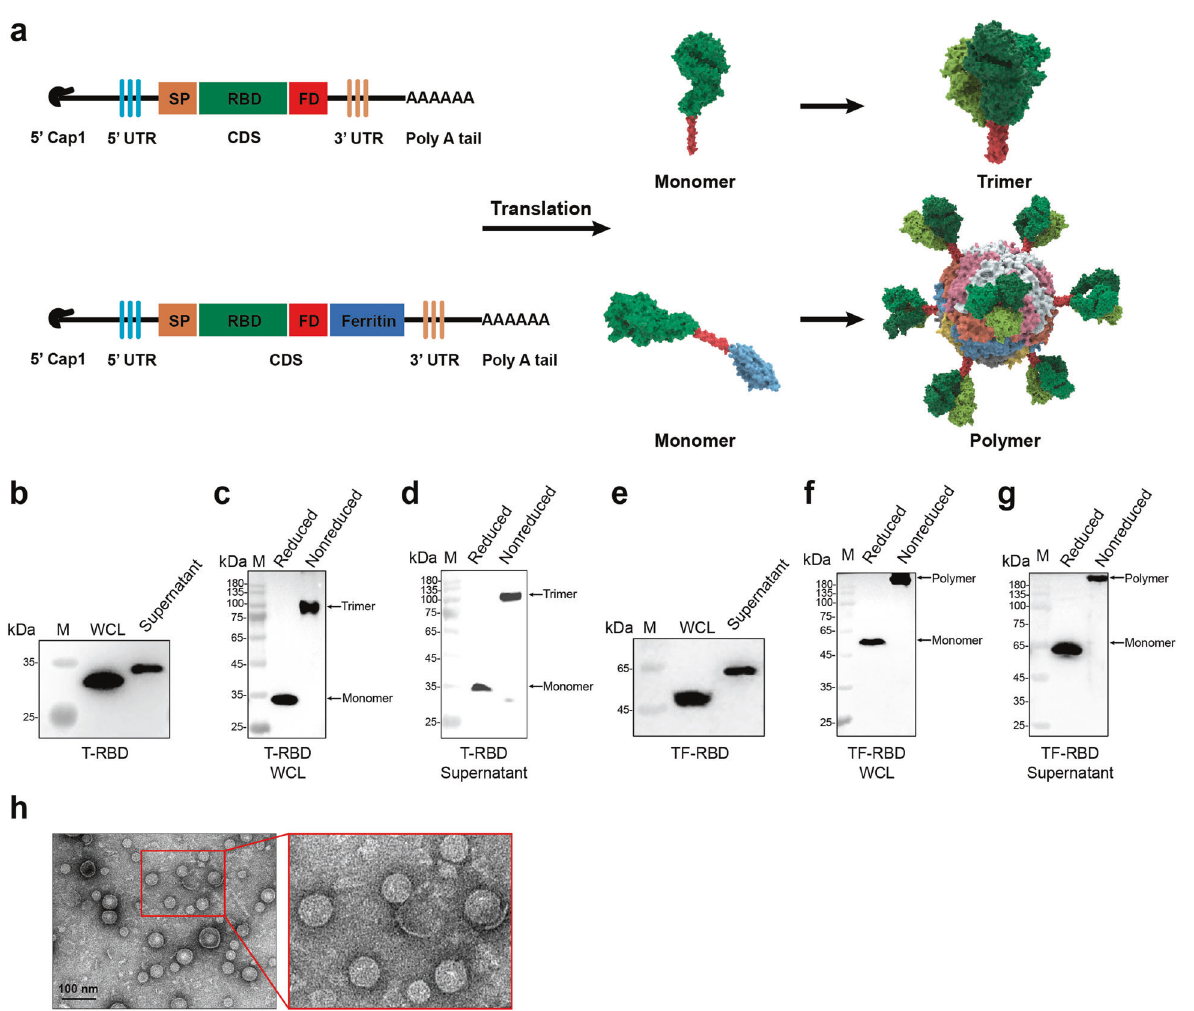
Fig. 1 Trimeric form of SARS-CoV-2 RBD (T-RBD) and the self-assembled ferritin nanoparticle form of SARS-CoV-2 RBD (TF-RBD). a Schematics of the T-RBD and TF-RBD designs. The RBD (R391-D541) of the SARS-CoV-2 spike (S) protein containing the N-terminal tPA signal peptide (SP) and the C-terminal foldon (FD) trimer tag or linked to ferritin (N96 mutation; increase protein secretion) gene sequences of Helicobacter pylori was synthesized in a DNA plasmid by codon optimization. The modi fi ed mRNA was synthesized by the in vitro transcription (IVT) of a linearized DNA plasmid. b The expression of the T-RBD protein in the whole-cell lysate (WCL) and supernatant was analyzed by western blot. c , d Western blot pro fi les of T-RBD protein expression under reduced and nonreduced conditions. e The expression of the TF-RBD protein in the WCLs and concentrated supernatant was analyzed by western blot. f , g Western blot pro fi les of TF-RBD protein expression under reduced and nonreduced conditions. h Transmission electron microscopy (TEM) images showing nanoparticles formed by TF-RBD expressed in the supernatant of HEK293T cells (scale bar, 100